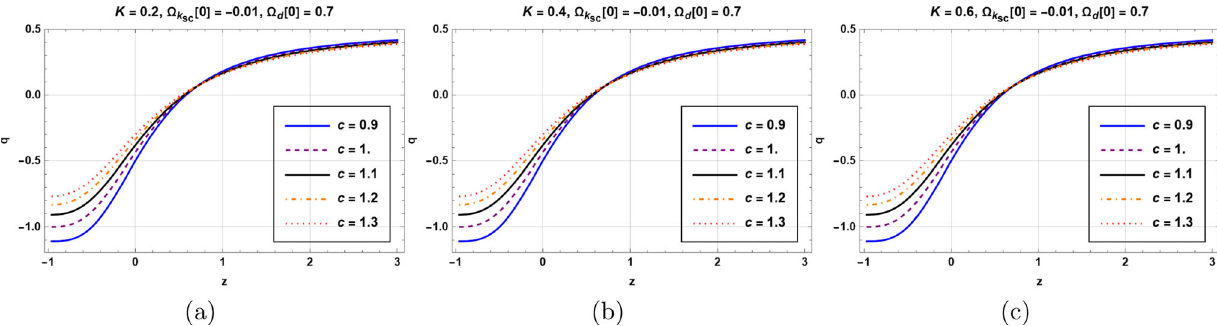
Fig. 5 The variation in the deceleration parameter q with redshift z for the closed universe, in units when M 2 p = 1 , H 0 = 67 . 9. In order to be consistent with data, we now imposed (cid:2) d ( x = − ln ( 1 + z ) = 0 ) = (cid:2) d [ 0 ] = 0 . 7